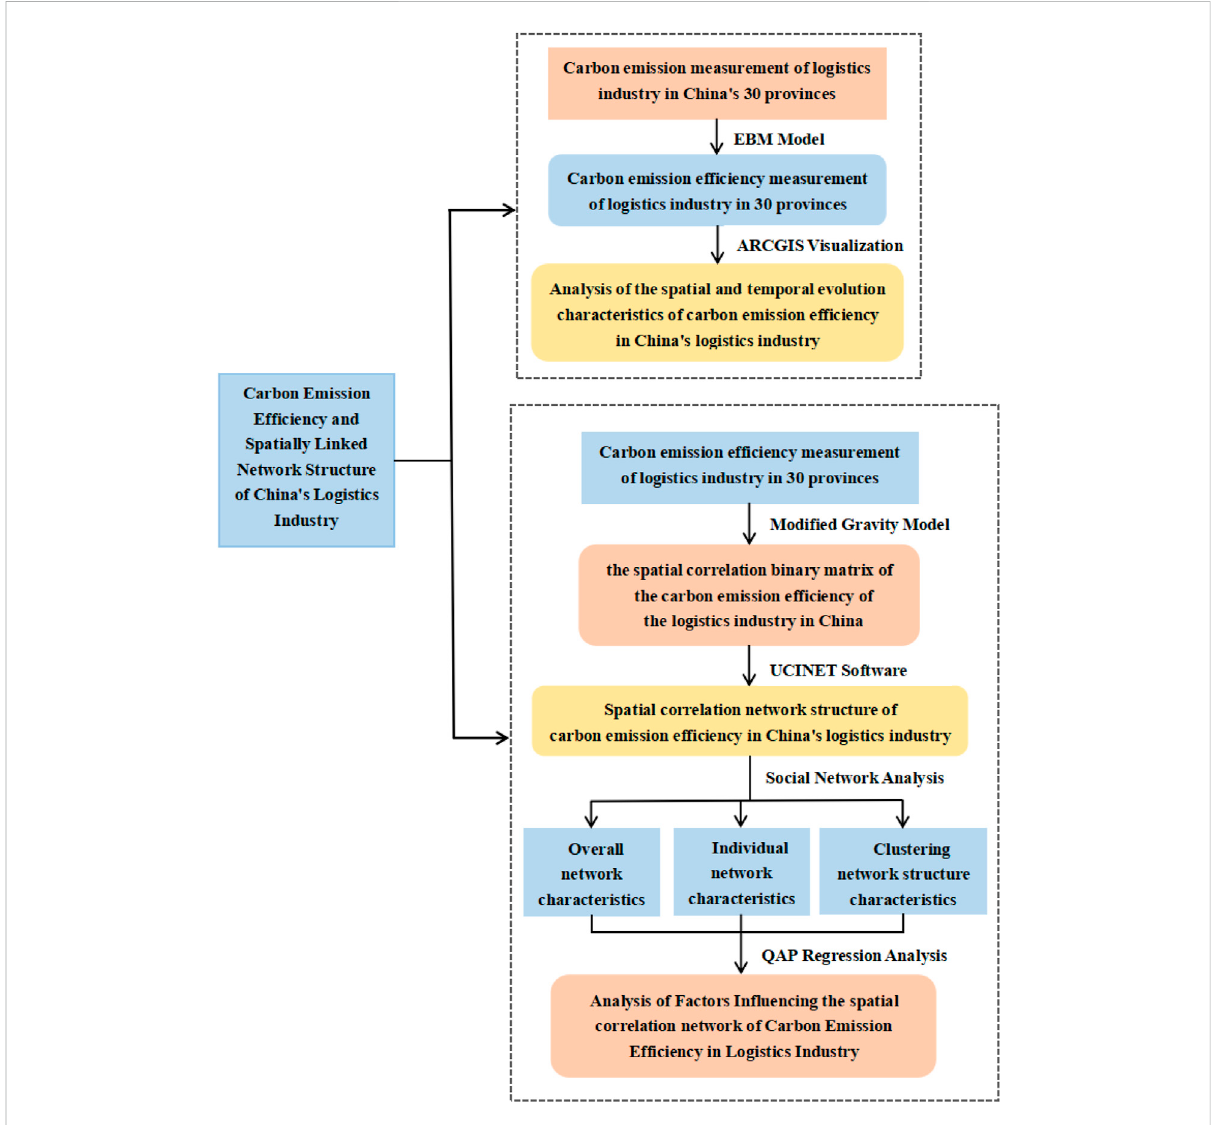
FIGURE 1 Technology roadmap of this